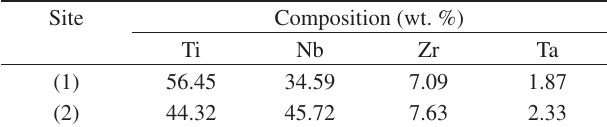
Figure 4. α -phase (1) and β -phase (2) areas analyzed for EDS in Ti-35NB- 7Zr-5Ta. Table 2. Ti, Nb, Zr and Ta contents in the areas analyzed (EDS).